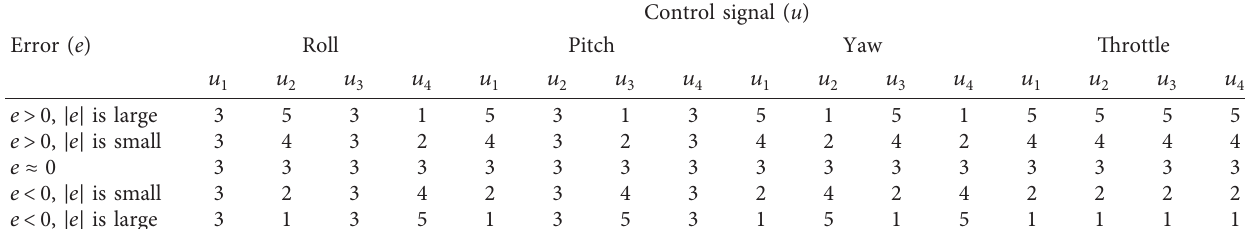
Table 1: Fuzzy control rules.